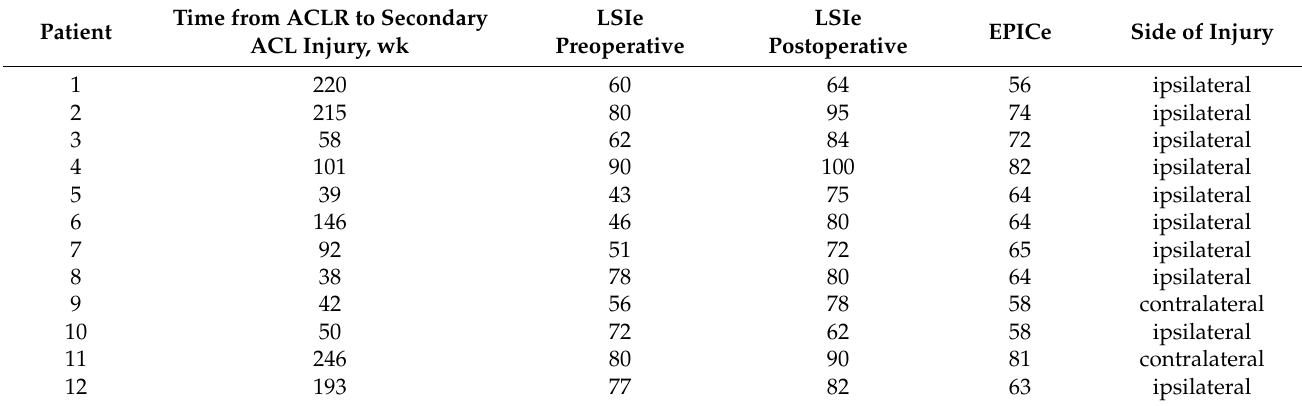
Table 4. Patients with secondary ACL injuries and LSIs and EPIC levels of knee extension strength.